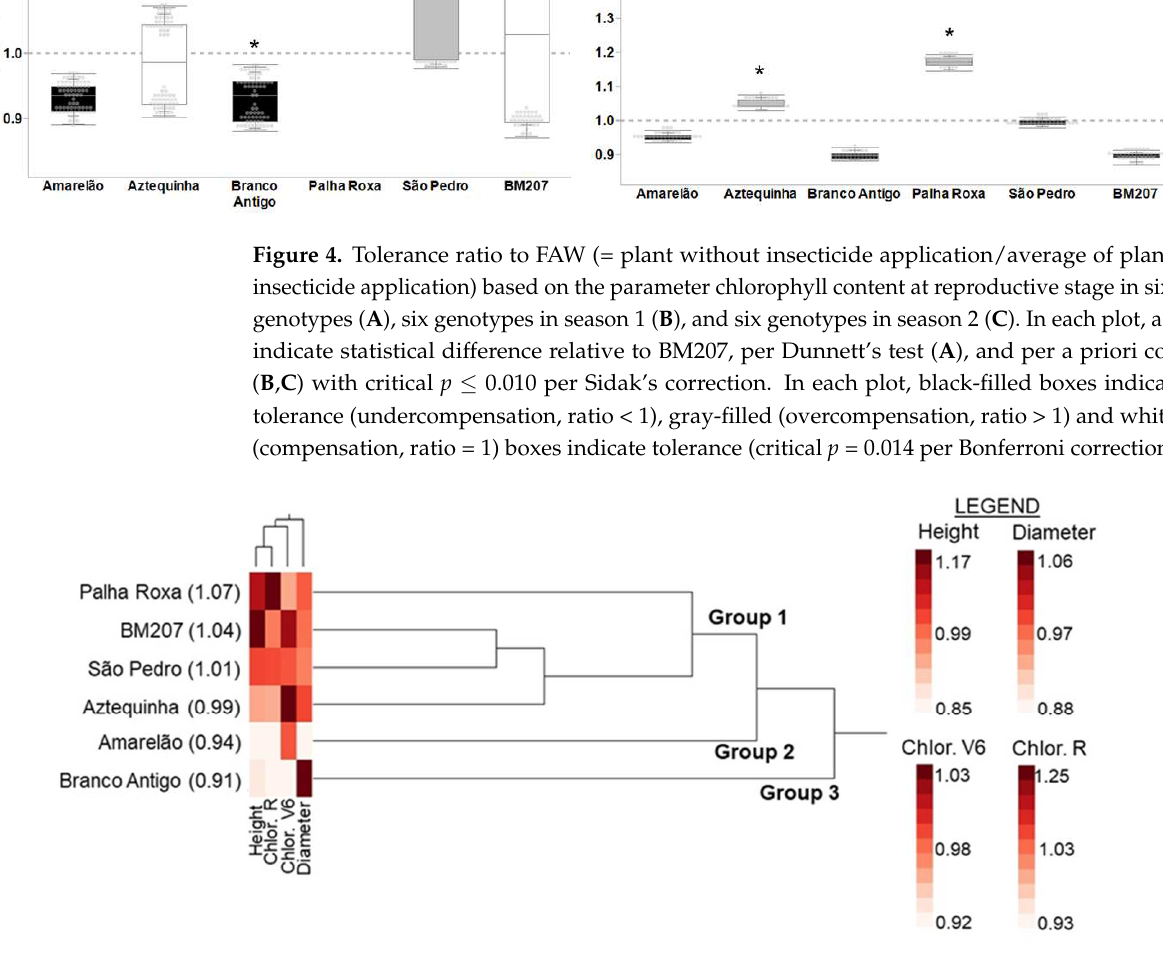
Figure 5. Hierarchical clustering and heat map for three FAW tolerance ratios (see text): Plant height (Height), chlorophyll content at V6 stage (Chlor. V6) and at reproductive stage (Chlor. R), and stem diameter (Diameter). The heat map shows changes (within columns) in tolerance ratios across plant genotypes (see Legend: intense color = highest tolerance, light color = lowest tolerance). Numbers following the genotypes are geometric averages of the four tolerance ratios; averages of 1.0 and above suggest tolerance, while averages below 1.0 suggest non-tolerance [59].